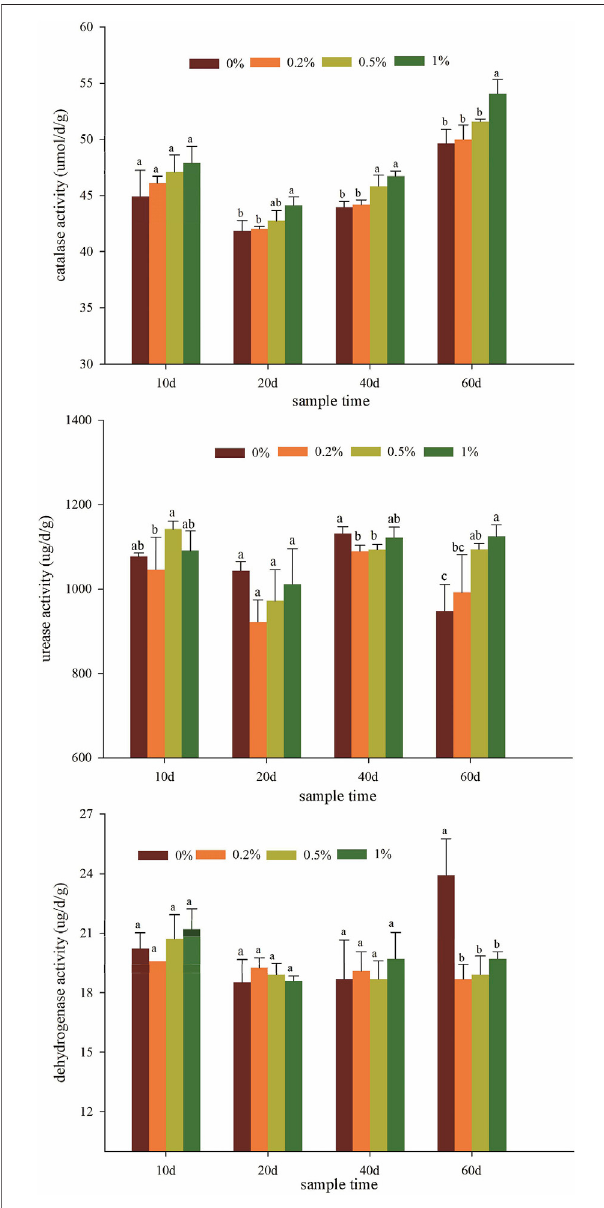
FIGURE4 | Effects ofNMMT application onthe activities ofcatalase (A) , urease (B) and dehydrogenase (C) . Letters above the bar diagram refer to the difference at a signi fi cance level of p <